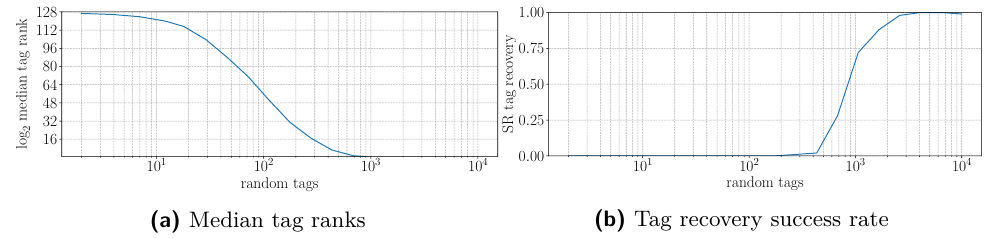
Figure 2: Median tag rank & success rate for various number of traces on ARM Cortex-M4. Metrics estimated on 100 independent random keys. 2 · 10 6 profiling traces